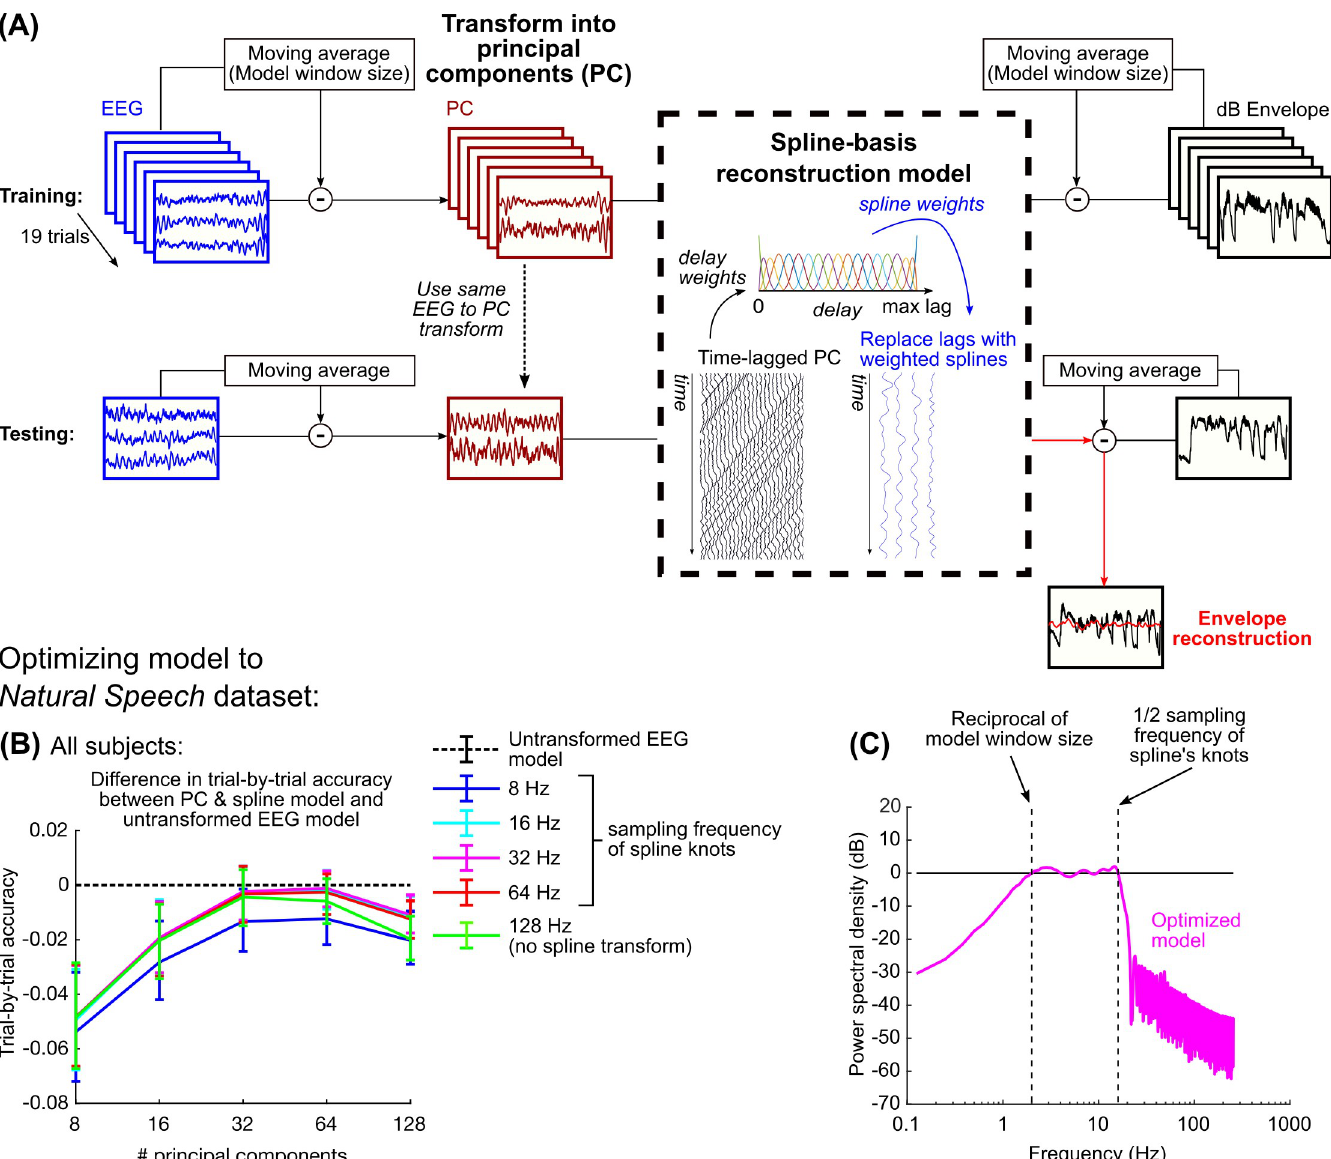
Fig 2. (A) Diagram of the stages for fitting the PCA & spline model. Throughout this study, the model is trained on all trials with one left out and tested on the left-out trial. (B) The difference in reconstruction accuracy (Pearson’s r) between the PCA & spline method and a standard approach based on regularized linear regression for each of the left-out trials was then examined; negative values mean that the standard approach performs better. Error bars show the interquartile range of the reconstruction accuracy differences. Of all hyperparameter pairs, only 64 PCs and spline knots sampled at 32 Hz exhibited performance that was no different than the standard approach. (C) The combined effect of removing the moving average and using basis splines restricts the frequency content of the reconstruction to a three- octave range; for a 500 ms window, this is restricted from 2–16